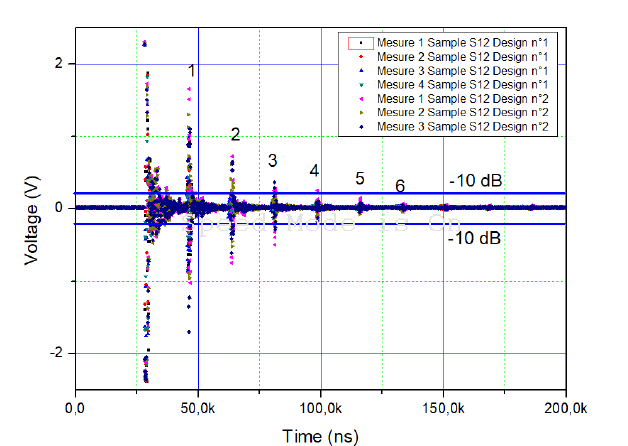
Figure 9 : Acoustics echoes measuring in Pulse/echo mode for designs n°1 and